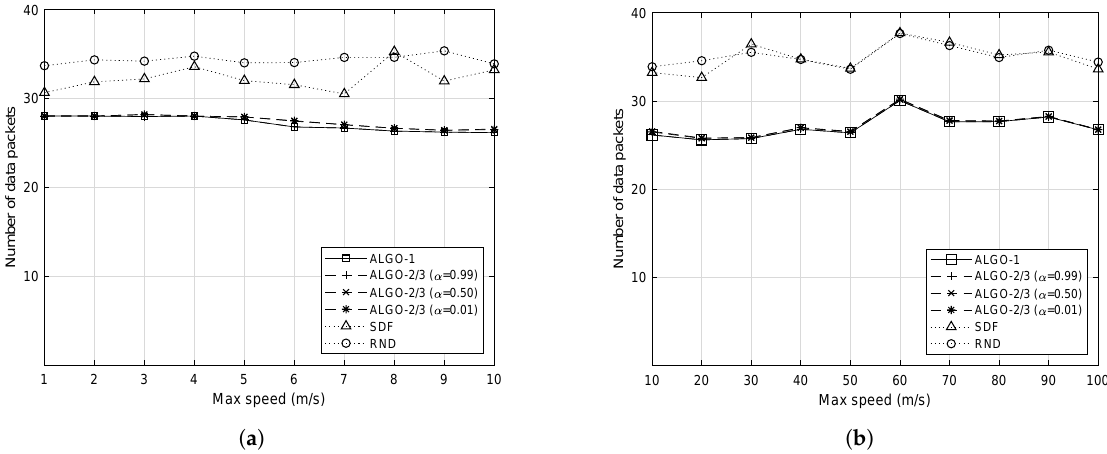
Figure 4. Average maximum load among RRHs with respect to different upper bounds of the speed in a system with 50 mobile IoT devices. ( a ) When IoT devices are moving at a slow speed; ( b ) When IoT devices are moving at a fast